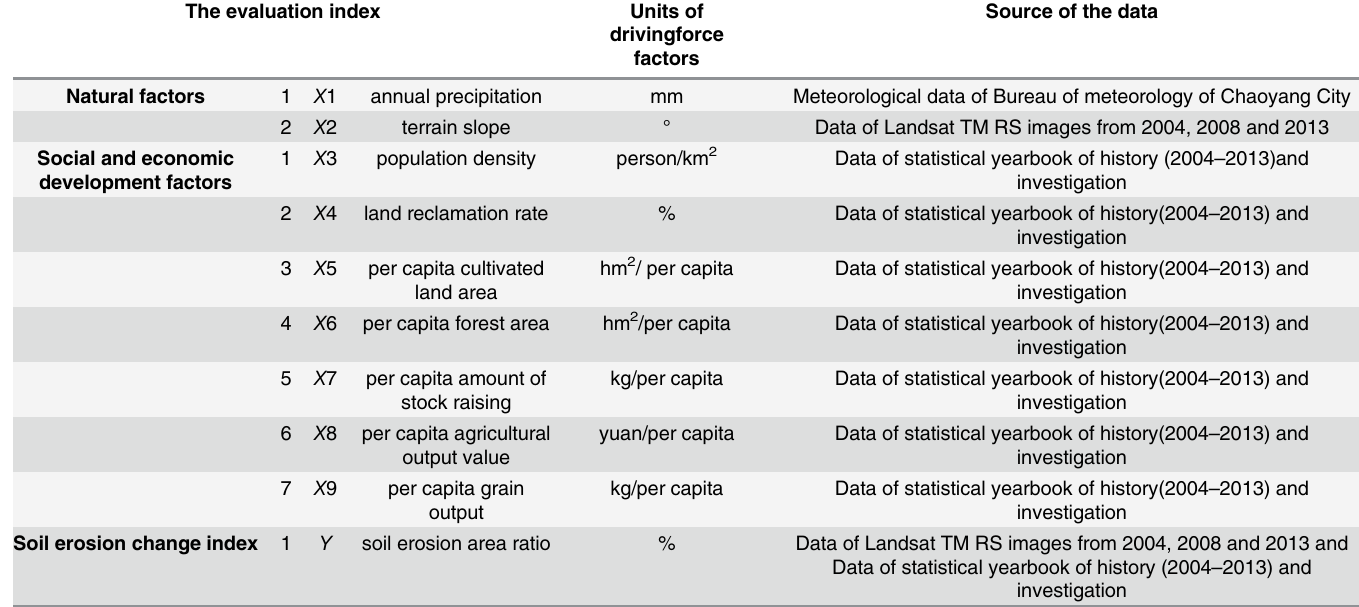
Table 1. Evaluation index system of the driving force factors of soil erosion.